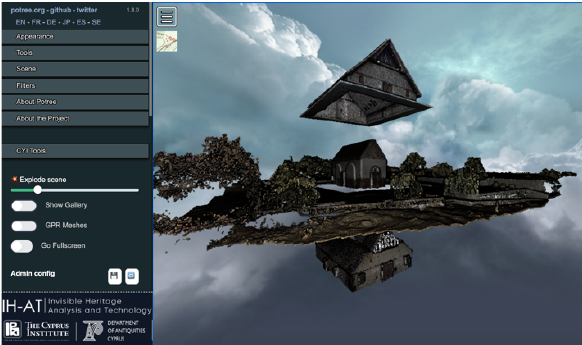
Figure 14. Panagia tis Podithou, Galata, explosion tool.